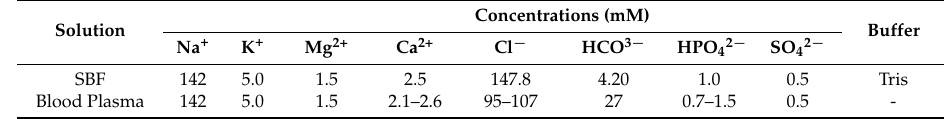
Concentrations (mM)